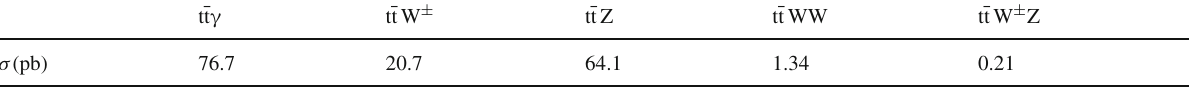
Table6.3 NLOcrosssectionsforassociatedproductionoftopquarkpairsandgaugebosons[172,173].Thephotonissubjecttothecut p and Frixione isolation with R 0 = 0 . 4